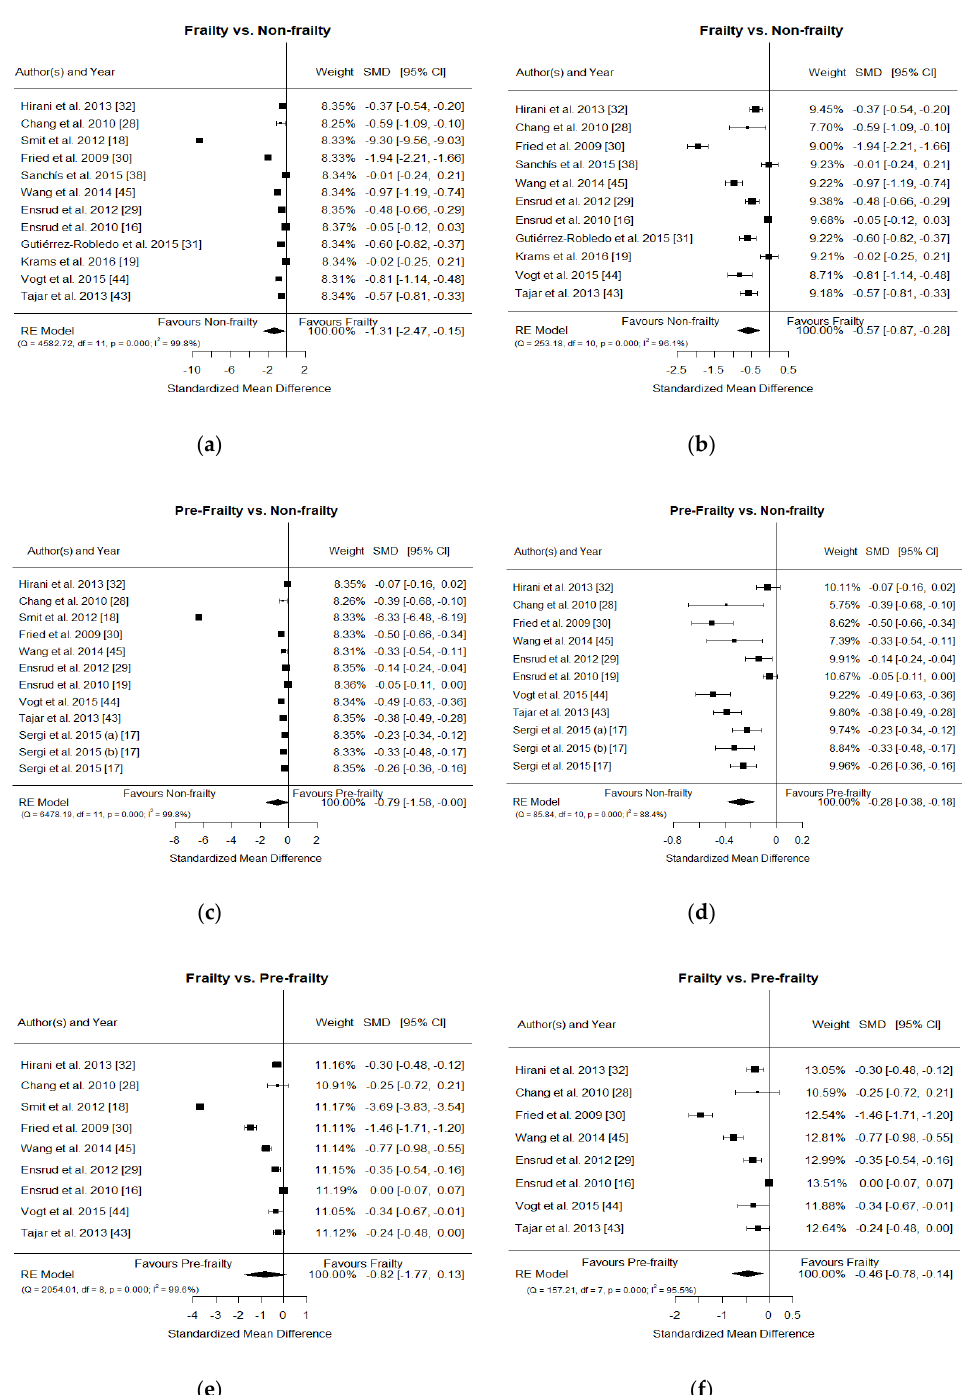
Figure 2. Forest plots for frailty vs. non-frailty comparison ( a , b ), pre-frailty vs. non-frailty comparison ( c , d ), and frailty vs. pre-frailty comparison ( e , f ); forest plots including all studies ( a , c , e ) and sensitivity analyses excluding Smit et al. [18] ( b , d , f ) are depicted. In order to respect original data provided by Sergi et al. [17], three populations from this study which differ in the number of positive criteria to classify pre-frail subjects were included in the meta-analyses comparing pre-frailty vs. non-frailty: pre-frail subjects with only one positive frailty criterion were embodied in “Sergi et al. 2015 ( a ) [17] ”; pre-frail subjects with two positive criteria were embodied in “Sergi et al. 2015 ( b ) [17]”; and all pre-frail subjects (with one and two positive criteria) were embodied in “Sergi et al. 2015 [17]”. RE: random-e ff